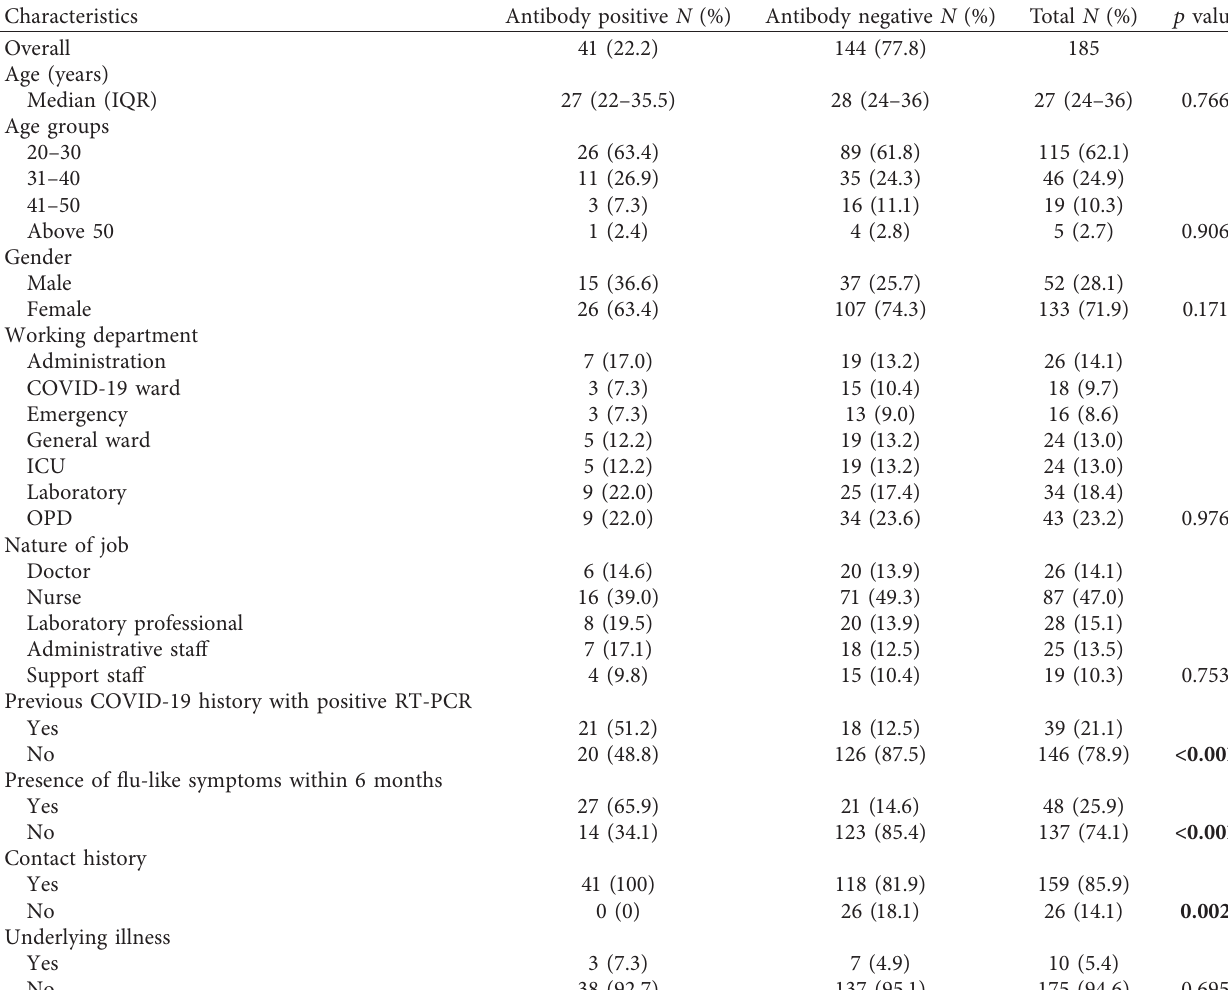
Figure 1: Antibody screening among HCWs. Table 1: Subjects characteristics and group